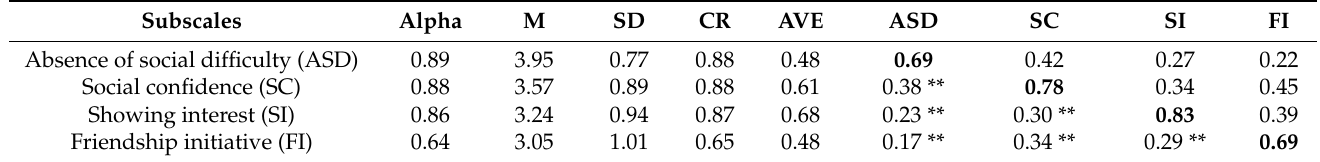
Table 3. Descriptive statistics, intercorrelations, reliabilities, and validities for the